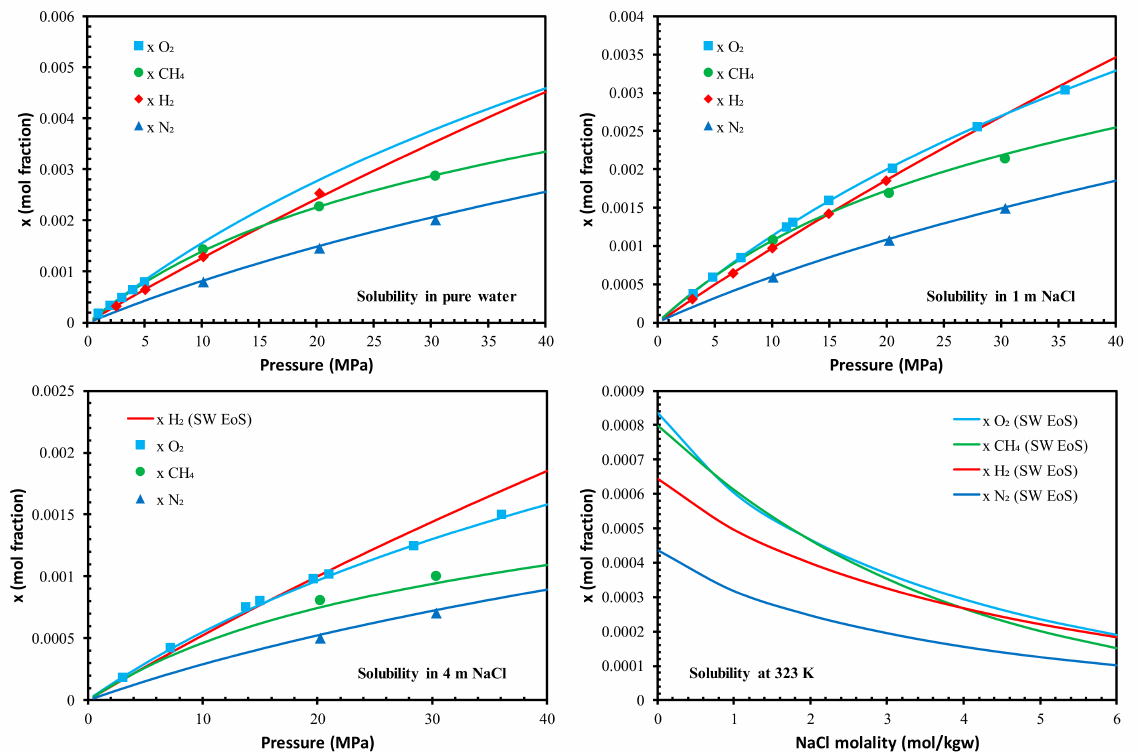
Figure 8. CH 4 , N 2 , O 2 and H 2 solubility in water and NaCl brine at 323 ± 1 K: Comparison of SW EoS predictions (solid lines) with experimental literature data (symbols)